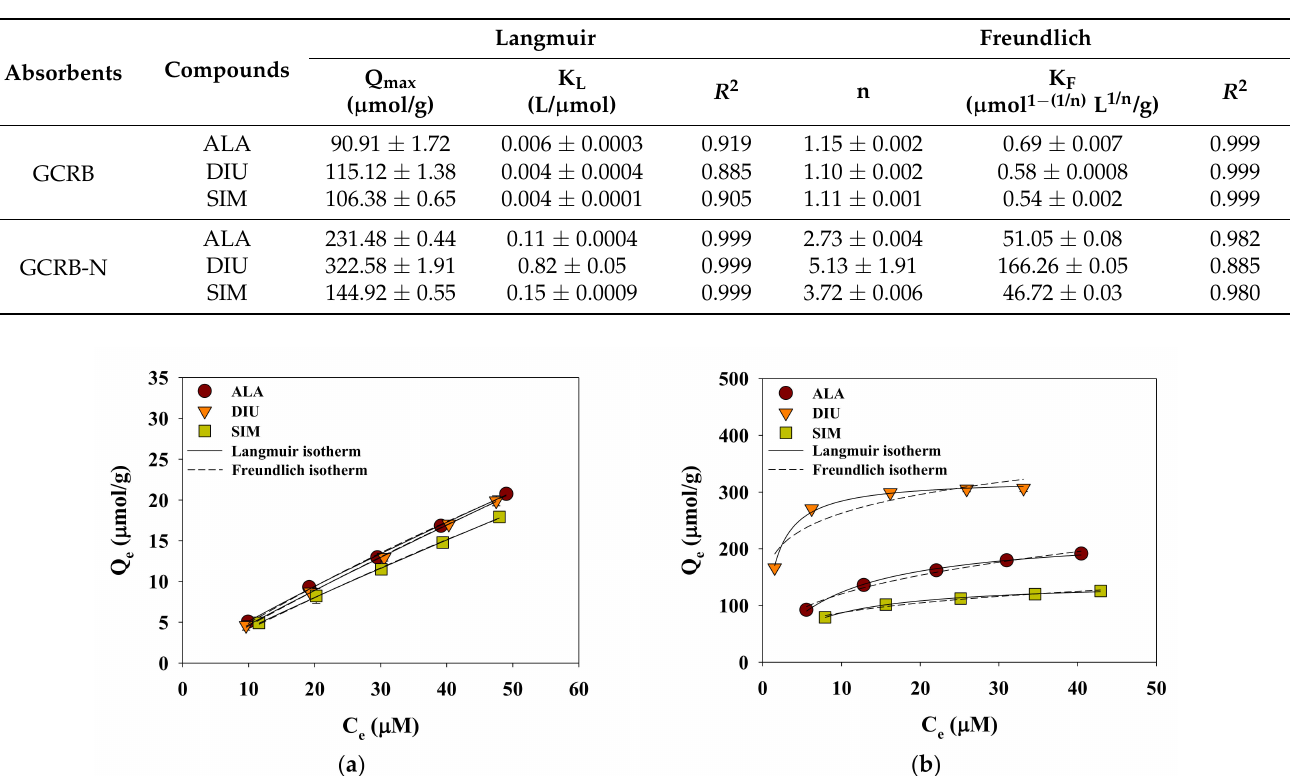
Table 4. Isotherm parameters for the competitive adsorptions of herbicides using the GCRB and GCRB-N (agitation speed = 150 rpm, contact period = 24 h, absorbent dosage = 50 mg/L, initial concentration of each herbicide = 10 µ M, pH = 7.0, and temperature = 25 °C).